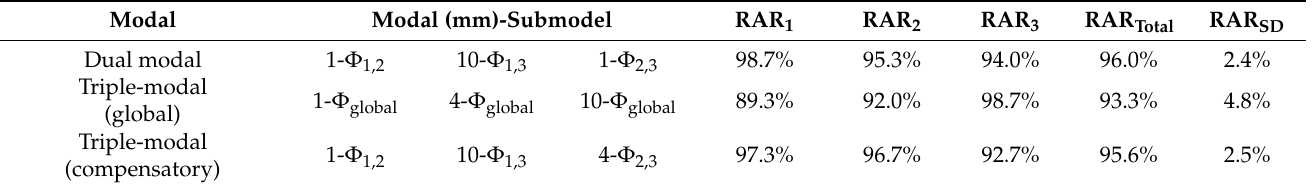
Table 7. Modeling discrimination effects of the optimal joint models for three-model voting fusion based on